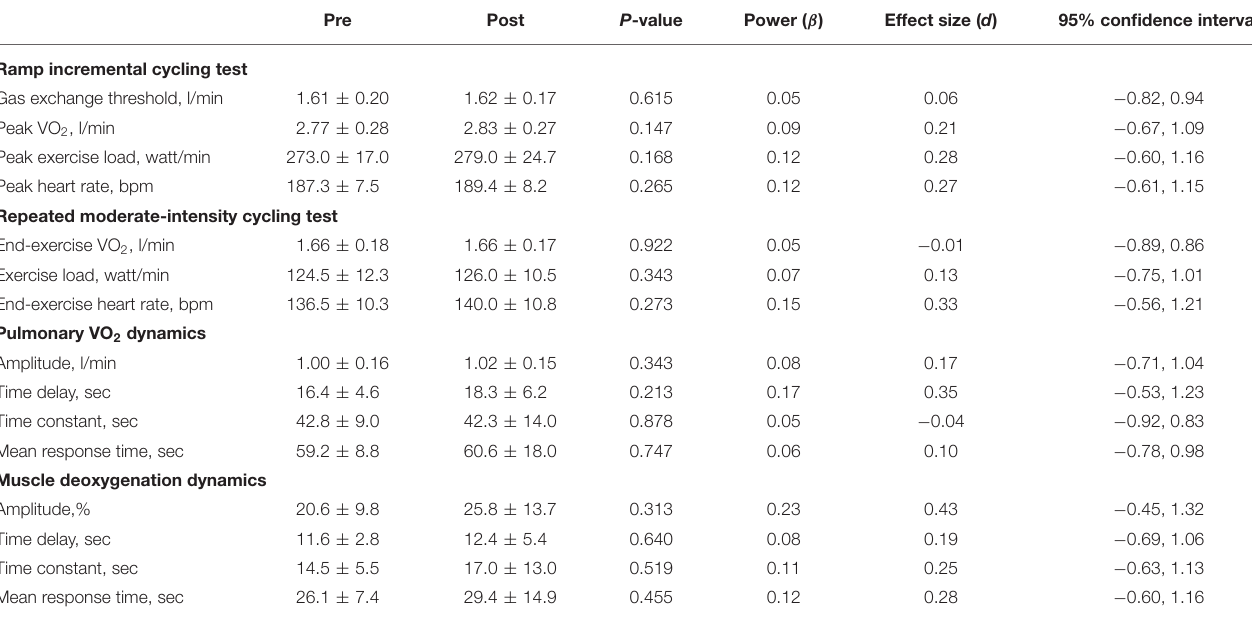
TABLE 1 | Changes in measured variables during ramp-incremental cycling and repeated moderate-intensity cycling tests before and after a 2-weeks ischemic preconditioning intervention. Pre Post P